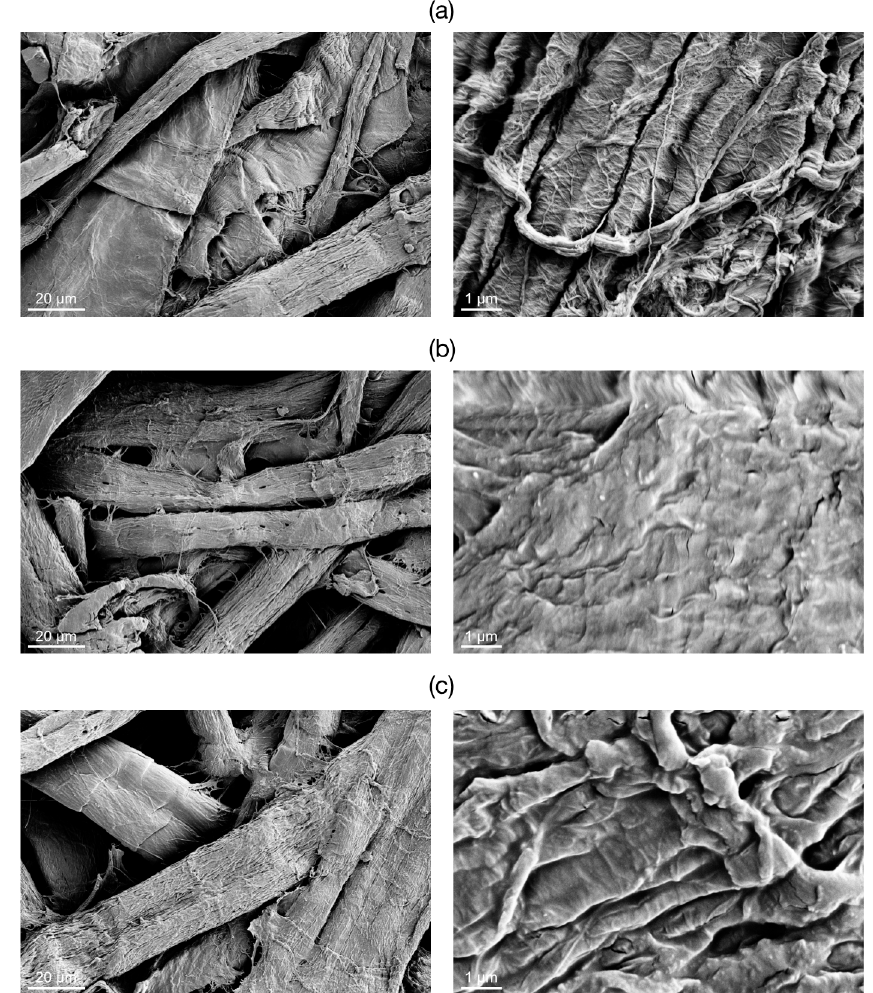
Figure 4. Low (left) and high (right) magnification SEM images of ( a ) the raw paper substrate and Paper-NBB80h samples, before ( b ) and after ( c ) rinsing in ultrasound bath. Images on the left were taken at the same level of magnification of those in Figure 1; images on the right were taken at a constant higher level of magnification.